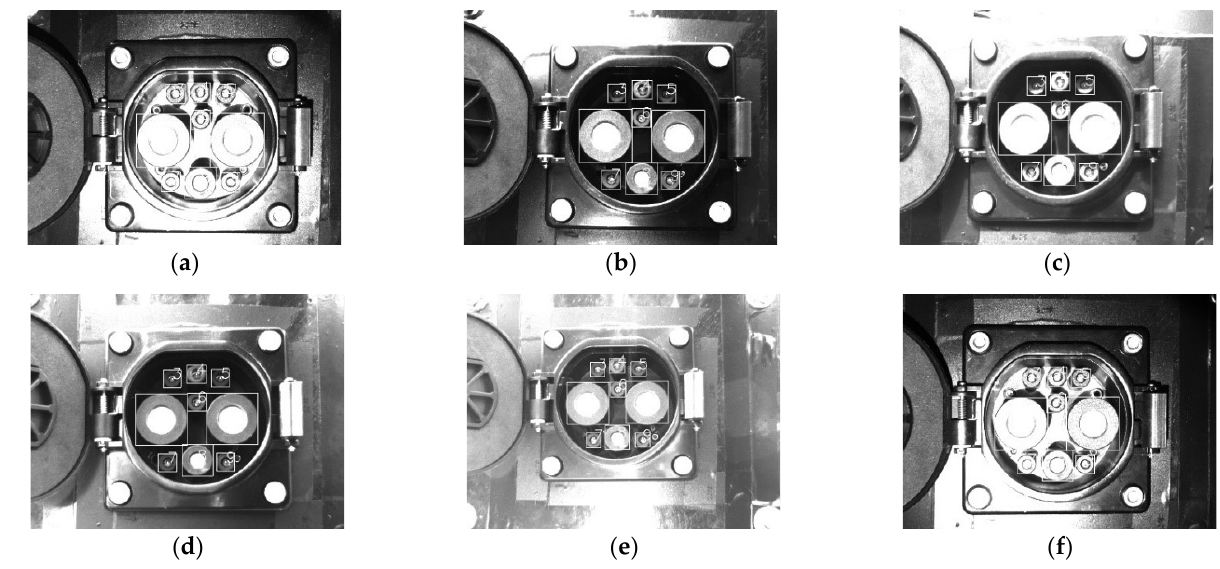
( f ) Figure 9. The recognition effect results in different scenarios in the search phase. ( a ) Indoor sunny day/overcast day time 1/time 3. ( b ) Outdoor sunny day time 1/time 3. ( c ) Outdoor sunny day time 2. ( d ) Outdoor overcast day time 1/time 3. ( e ) Outdoor overcast day time 2. ( f ) Time 4. Table 3. Pose solution errors in the search phase. Scenes